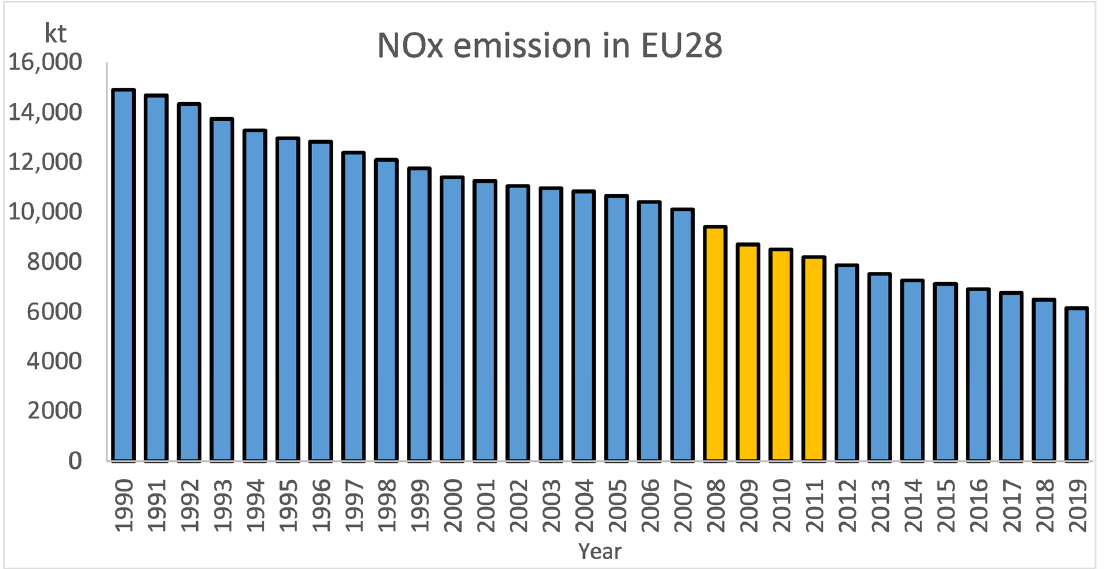
Figure 1. Emissions of nitrogen oxides NOx as NO 2 for EU28 from EMEP. Yellow colours of bars represent the years of analysis in the presented work, and blue bars represent other years.